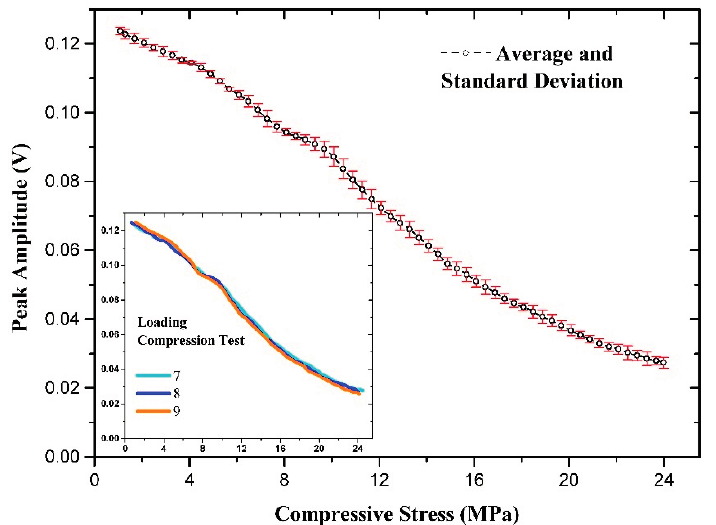
Figure 11. Averaged and standard deviation of the peak